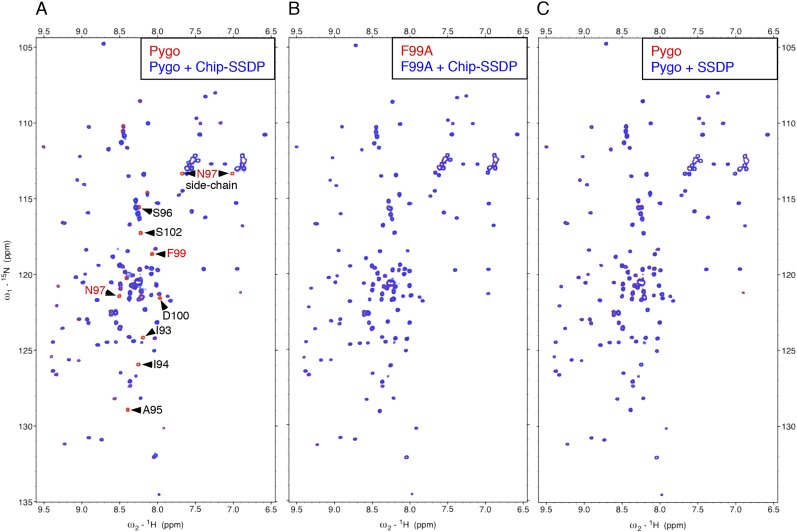
Direct NPF-dependent binding of Pygo by ChiLS.Overlays of HSQC spectra of 50 μM 15N-labeled wt or F99A mutant Pygo67-107 alone (red) or probed with (A, B) MBP-Chip205-436- Lip-SSDP1-92 or (C) Lip-SSDP1-92 alone (blue); interacting residues are labeled, with NPF in red (binding to P is not detectable by HSQCs). The HSQC obtained with 50 μM of minimal 15N-labeled Pygo87-102 is indistinguishable from that shown in (A).